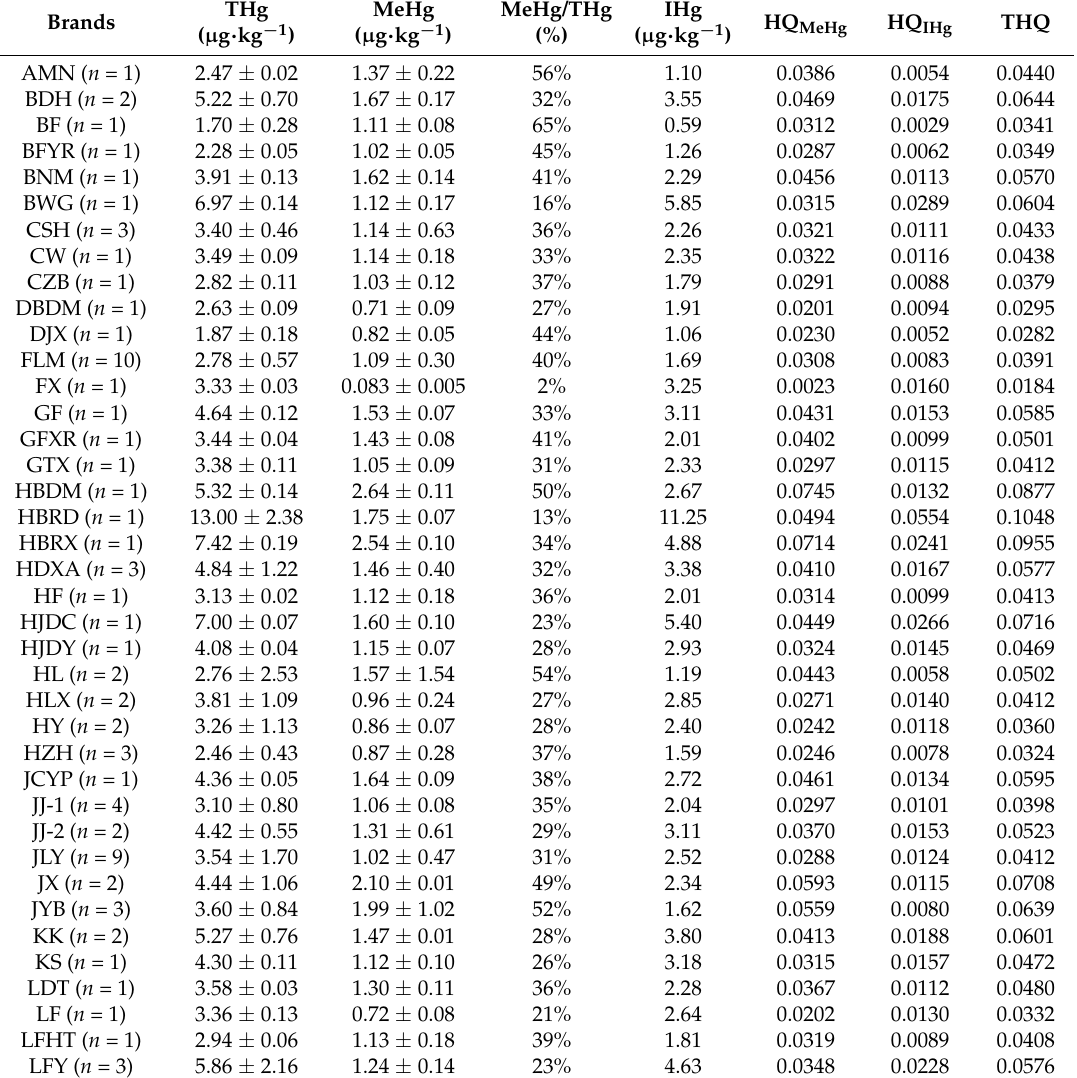
Table 2. The mean values of THg, MeHg, MeHg/THg, IHg, HQ of MeHg and IHg, and THQ indifferent brands of